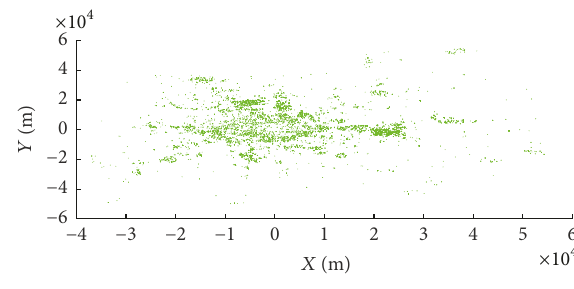
Figure 4: Scatterplot of the passenger trip origins.